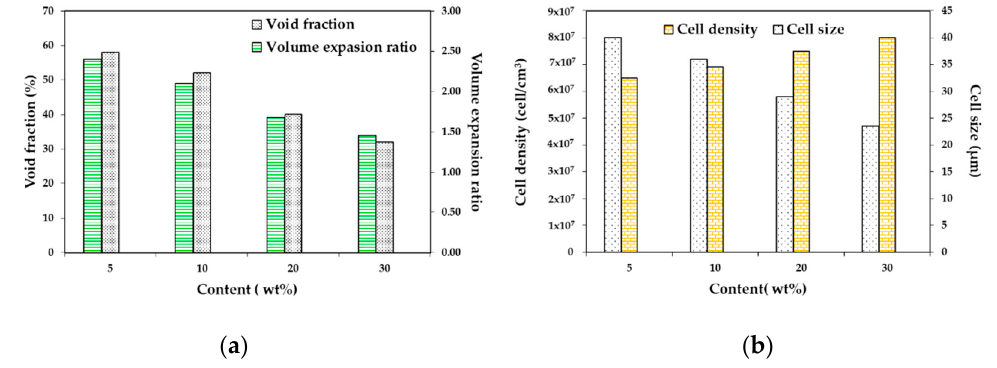
Figure 11. Effect of jute fiber content on the foam microstructure of the PLA/jute fiber biocomposites; ( a ) void fraction and volume expansion ratio and ( b ) cell size and cell density. Data taken from Zafar et al. [128].